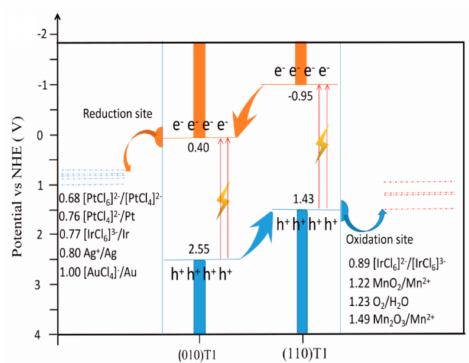
Figure 15. The band structure for the different heterojunctions. CB stands for conduct band and VB stands for valance band.